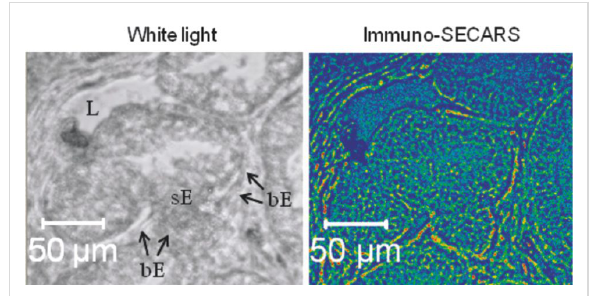
Figure 9: White light (left) and SECARS (right) images of prostate biopsies incubated with SERS-labeled p63-antibodies. p63 is only abundant in the p63-(+) basal epithelium (bE, arrows) but not in the p63-( − ) secretory epithelium (sE) and lumen (L). Figure adapted with permission from [82], Copyright 2011 American Chemical